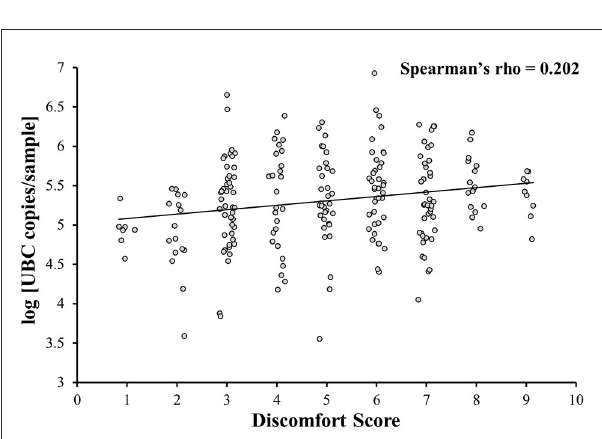
FIGURE2 Correlation between the level of discomfort and sample quality. Discomfort is weakly correlated with sample quality (samples A, B, and C